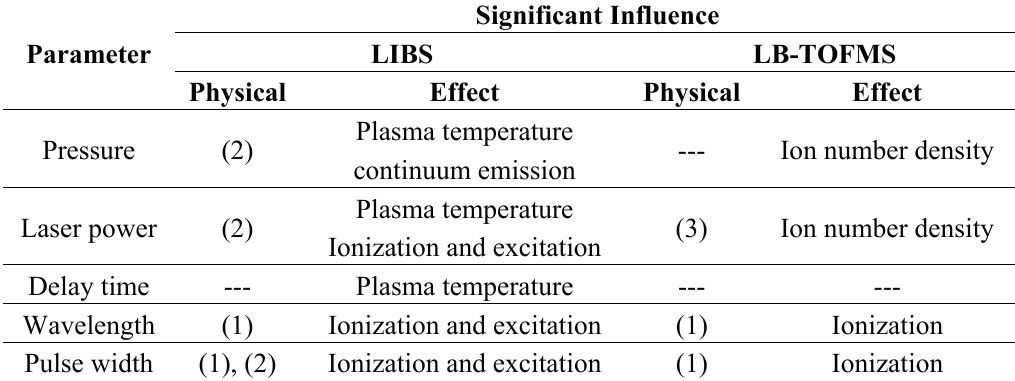
Table 1. Influence of LIBS and LB-TOFMS detection systems. The key physical processes consist of (1) multi-photon ionization, (2) electron impact ionization and (3)